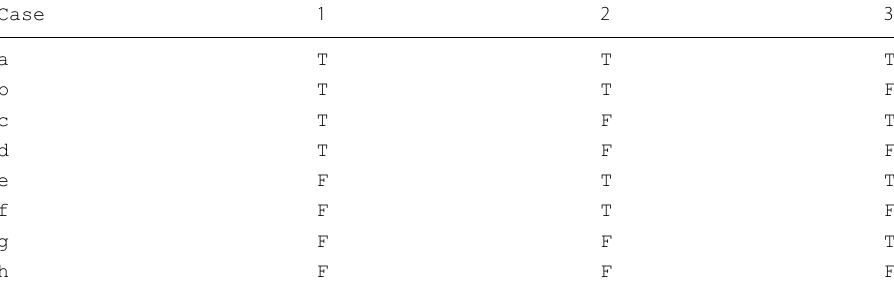
Table 2 Genetic algorithm possible feasibility conditions